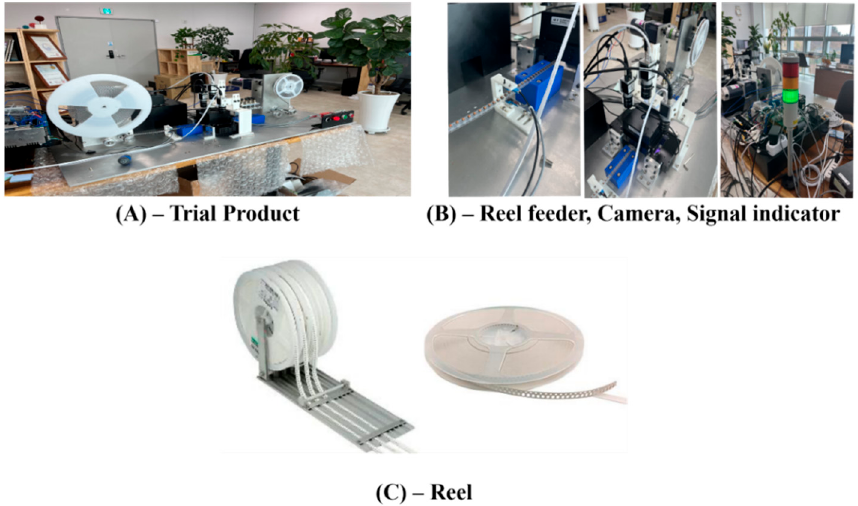
Figure 4. Experimental equipment for data acquisition and quality inspection.